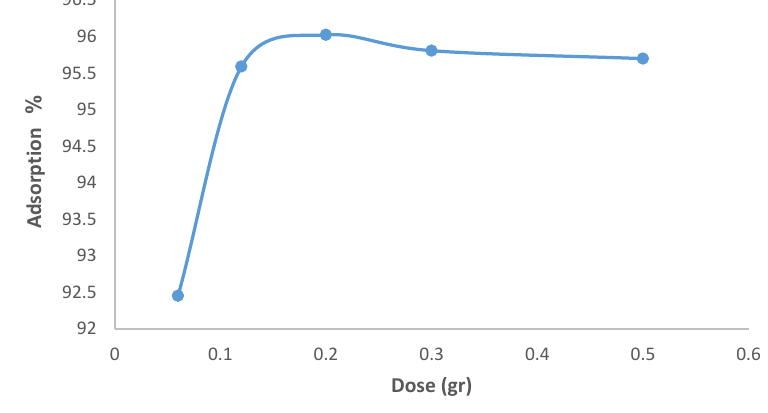
Figure 5. Effect of adsorbent dose (gr) on the adsorption of methyl orange dye at a concentration of 20 mg/L